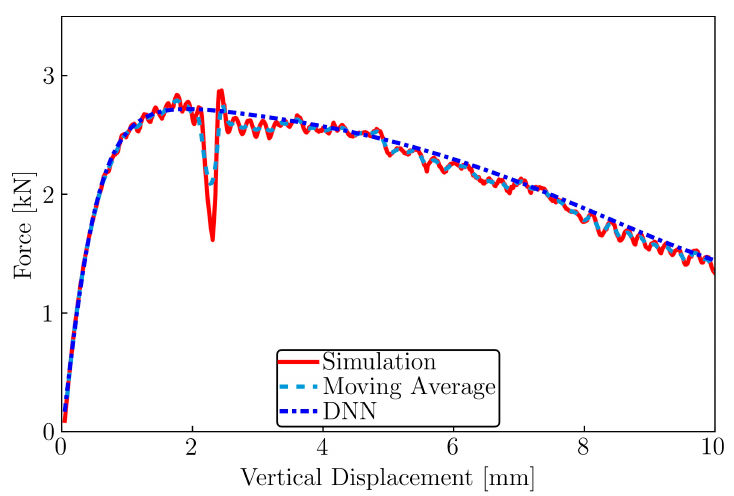
Figure 9. Comparison of simulation, moving average and dense neural network (DNN) force–ver- tical displacement diagram. displacement